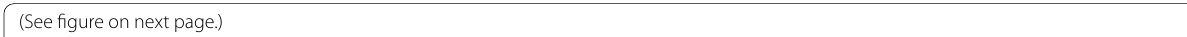
Fig. 4 Enzymes associated with cellular lipid metabolism. a Structures of ICL1 homotetramer (Left, PDB ID: 1F61) and ICL2 (Right, PDB ID: 6EDW). ICL2 forms an elongated structure with C-terminal dimers at each end of the structure. b Striking structural rearrangement of ICL2 upon binding to acetyl- CoA (PDB ID: 6EE1). In both a and b , each monomer is shown in different color. c The dimeric association of the C-terminal domains in the ligand-free (top) and acetyl-CoA-bound (bottom) ICL2. Acetyl-CoA is shown as sticks. d Left: structure of the ternary complex of the ICL1 with glyoxylate (GA) and 3-nitropropionate (shown as succinate, SA) (PDB ID: 1F8I). Right: Schematic diagram of ICL interactions with glyoxylate and succinate. e Structure of ICL1 in a complex with 3-bromopyruvate (PDB ID: 1F8M). Pyruvyl moeity (purple) is formed by covalently binding 3-bromopyruvate to C191 of ICL1. f Structure of pantothenate synthetase (PS, PDB ID: 3COV). A side view of the dimer structure shows that it resembles the shape of a butterfly. g Structures of PS in a complex with different substrates (ATP, pantoate, pantoyl adenylate, AMP and β-alanine), respectively. h - j Structure of PS in a complex with different inhibitors. Inhibitor 1, 5 ′ -O-{[(2R)-2-hydroxy-3,3-dimethylbutanoyl]sulfamoyl}adenosine; Inhibitor 2, (5-methoxy-2-{[(5-methylpyridin-2-yl)sulfonyl]carbamoyl}-1H-indol-1-yl)acetic acid; Inhibitor 3, 2-(2- (benzofuran-2-Ylsulfonylcarbamo yl)-5-methoxy-1H-indol-1-yl)acetic acid. The electrostatic potential in all figures was computed using the APBS tools in PyMol (http:// www.